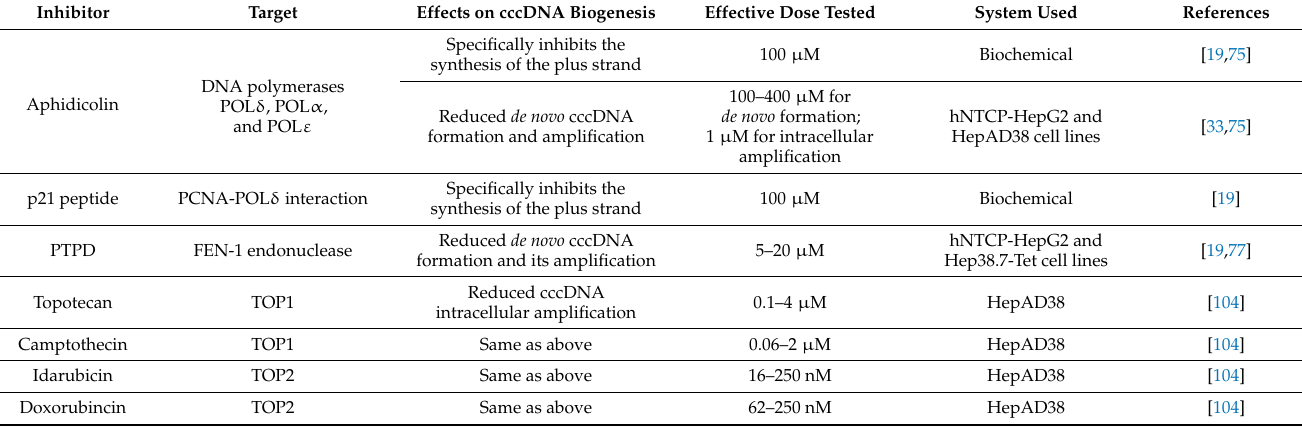
Table 1. Reported inhibitors of various DNA repair factors that reduce cccDNA levels in biochemical and cell culture assays. Inhibitor Target Effects on cccDNA Biogenesis Effective Dose Tested System